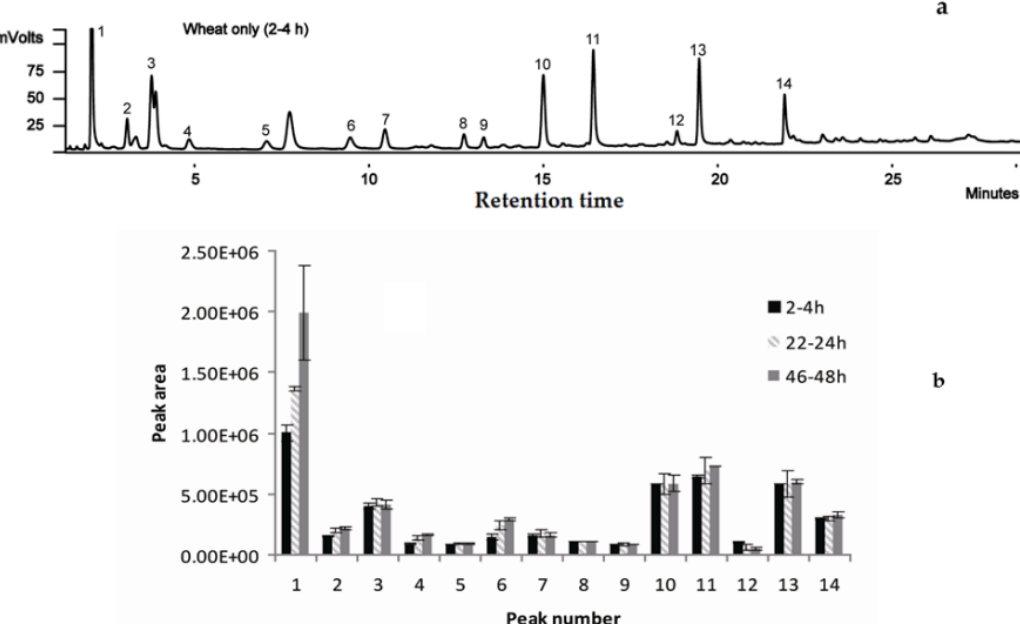
Figure 2. Comparison of mean GC responses of main peaks from healthy wheat collected at 2–4, 22–24, and 46–48 h after being sealed in an airtight container: ( a ) GC chromatograms of headspace volatiles from wheat only and ( b ) the GC peak areas of main peaks from healthy wheat collected at 2–4, 22–24, and 46–48 h after being sealed in an airtight container. Numbered peaks are: 1 = Acetone; 2 = Methanol; 3 = Ethanol; 4 = 2,3-Butanedione; 5 = 2-Butanol; 6 = Hexanal; 7 = 2-Methyl-1-propanol; 8 = 1-Butanol; 9 = 1-Penten-3-ol; 10 = 3-Methyl-1-butanol; 11 = 1-Pentanol; 12 = 3-Methyl-2-buten-1-ol; 13 = 1-Hexanol; and 14 = 1-Pentadecene. Each bar represents the average of three replicates and the error bars indicate standard deviation.